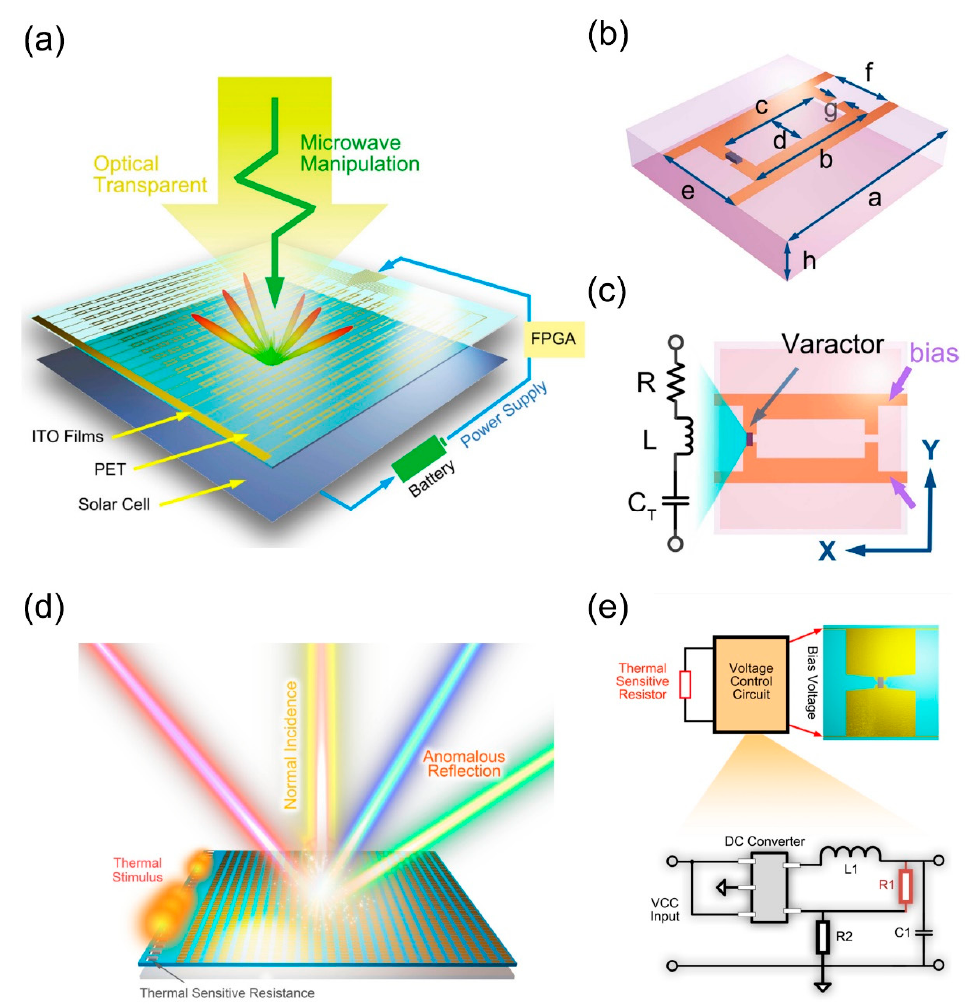
Figure 5. ( a ) The schematic of optical transparent and programmable metasurface integrated with varactor diodes (from Figure 1 of Ref. [113]). ( b ) Detailed structure of the metasurface element (from Figure 2a of Ref. [113]). ( c ) The equivalent RLC model of the varactor diode (from Figure 2b of Ref. [113]). ( d ) Schematic diagram of the programmable metasurface based on thermal sensor (from Figure 1 of Ref. [114]). ( e ) Detailed structure of the bias voltage control circuit. (from Figure